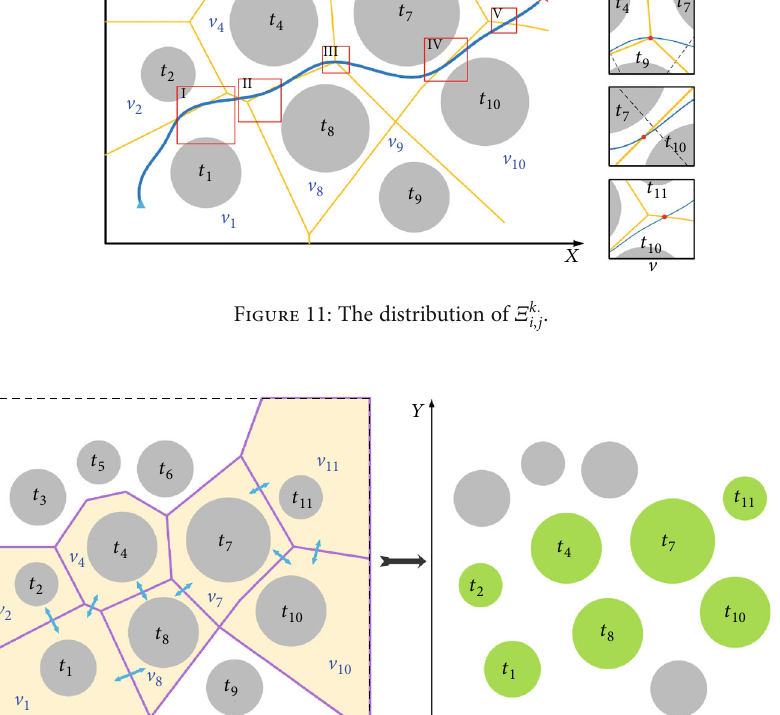
Figure 12: Associated convex polygonal areas and